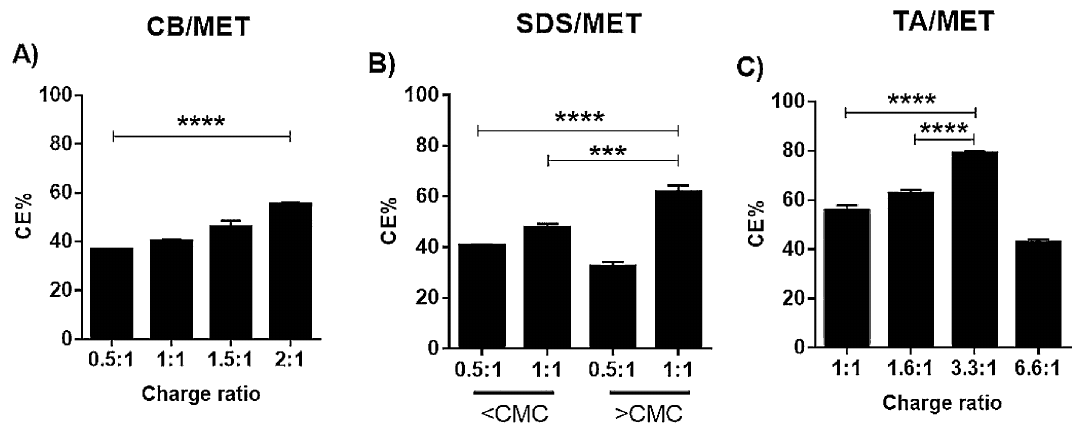
Figure 4. Complexation efficiency (CE%) of MET complexes. ( A ) Carbopol (CB), ( B ) sodium dodecyl sulfate (SDS), and ( C ) tannic acid (TA), prepared at various charge ratios (*** p ≤ 0.001, **** p < 0.0001, One-way ANOVA, Tukey’s multiple comparisons test, CMC; critical micelle